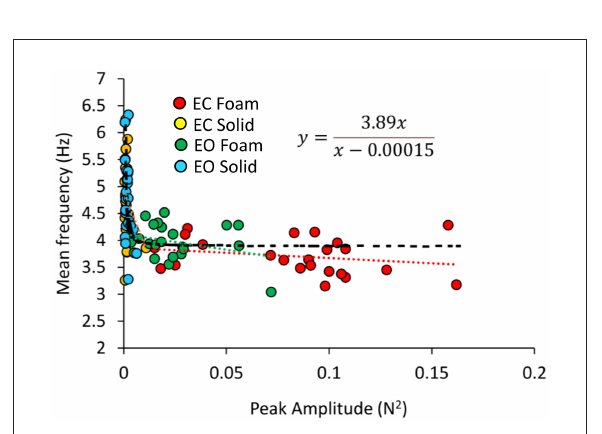
FIGURE6 Relationship between Mean frequency and Peak amplitude of the VGRF spectrum. For each subject, the values of the Mean frequency are plotted against those of the Peak amplitude of the Gaussian curve in the different visual and base of support conditions (EC Foam, red; EC Solid, yellow; EO Foam, green; EO Solid, blue). The data distribution showed a hyperbolic trend. The black dotted line corresponds to the hyperbola fitting the data (equation in the inset).